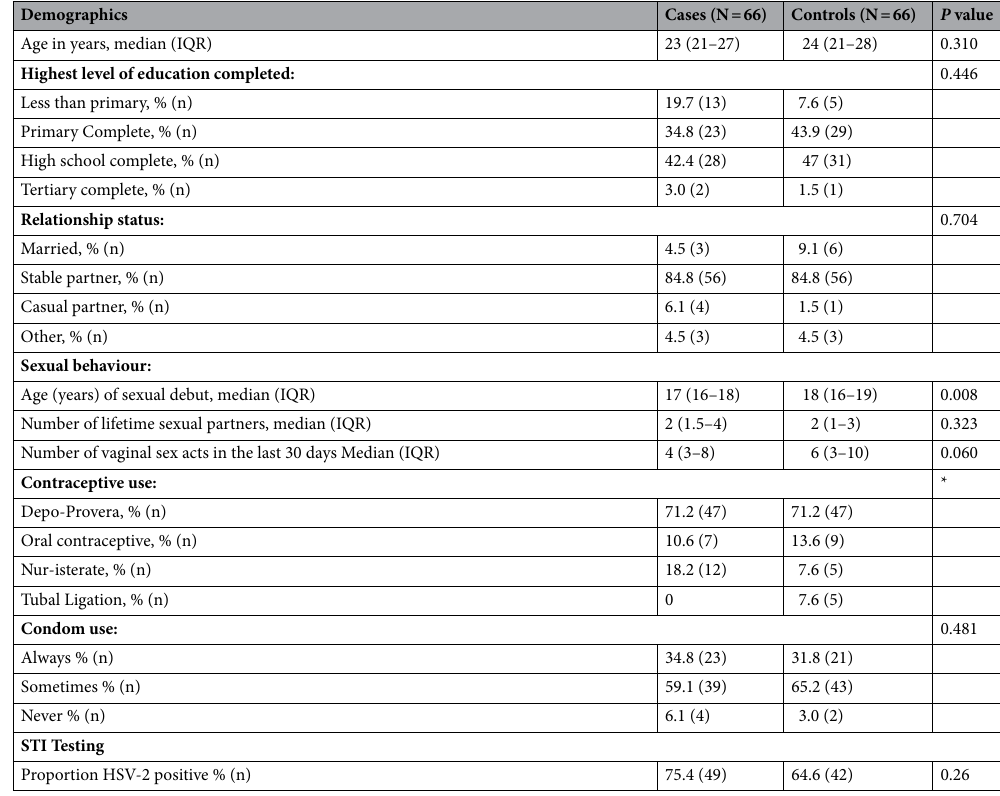
Table 1. Baseline characteristics of case and controls included in this study. IQR, interquartile range. HSV- 2, Herpes simplex virus-2. A p -value of < 0.05 was regarded as statistically significant. *The Bowker test of symmetry failed as there were no events hence the p-value could not be